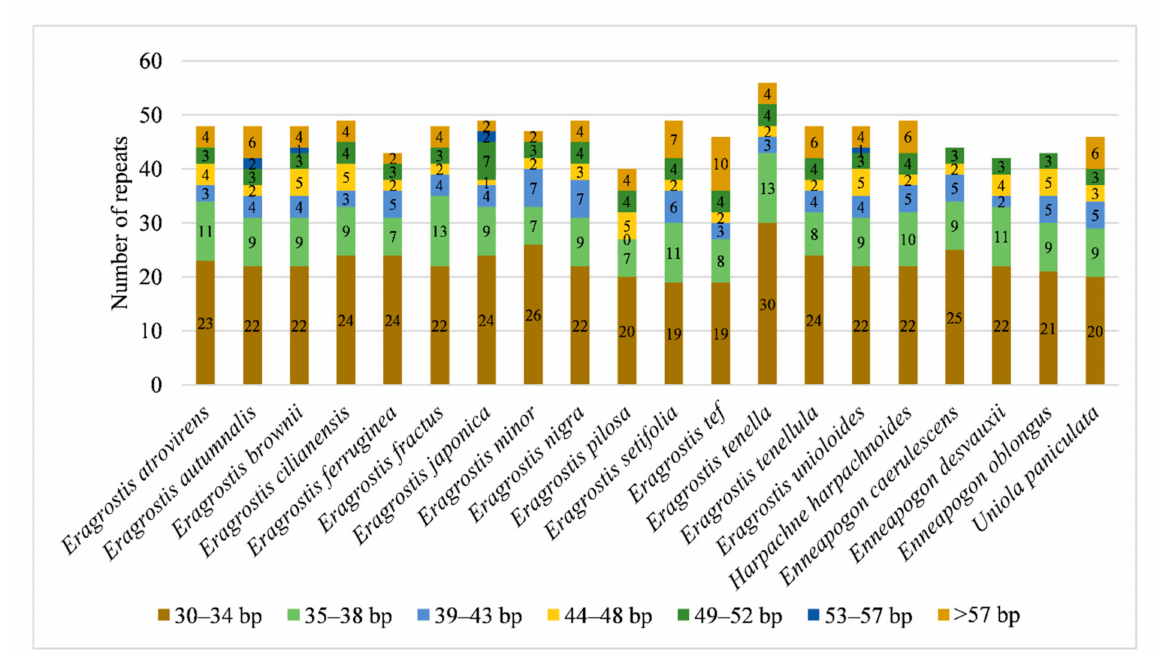
Figure 3. The number of repeats with different length in 20 Eragrostideae chloroplast genomes. A total of 943 SSRs were identified in the chloroplast genomes of 20 Eragrostideae species using MISA script. These SSRs were mainly distributed in the LSC region (Table 3). These SSRs were mononucleotide repeats and dinucleotide repeats, and the mononu- cleotide repeat type was mainly A/T repeat, while all the dinucleotide repeat sequences were composed of AT/TA repeats (Table 3). There were no trinucleotide or longer repeats in these chloroplast genomes. E. tenella had the largest number of SSRs (56), including 53 mononucleotide repeats (51 A/T repeats and two G/C repeats) and three